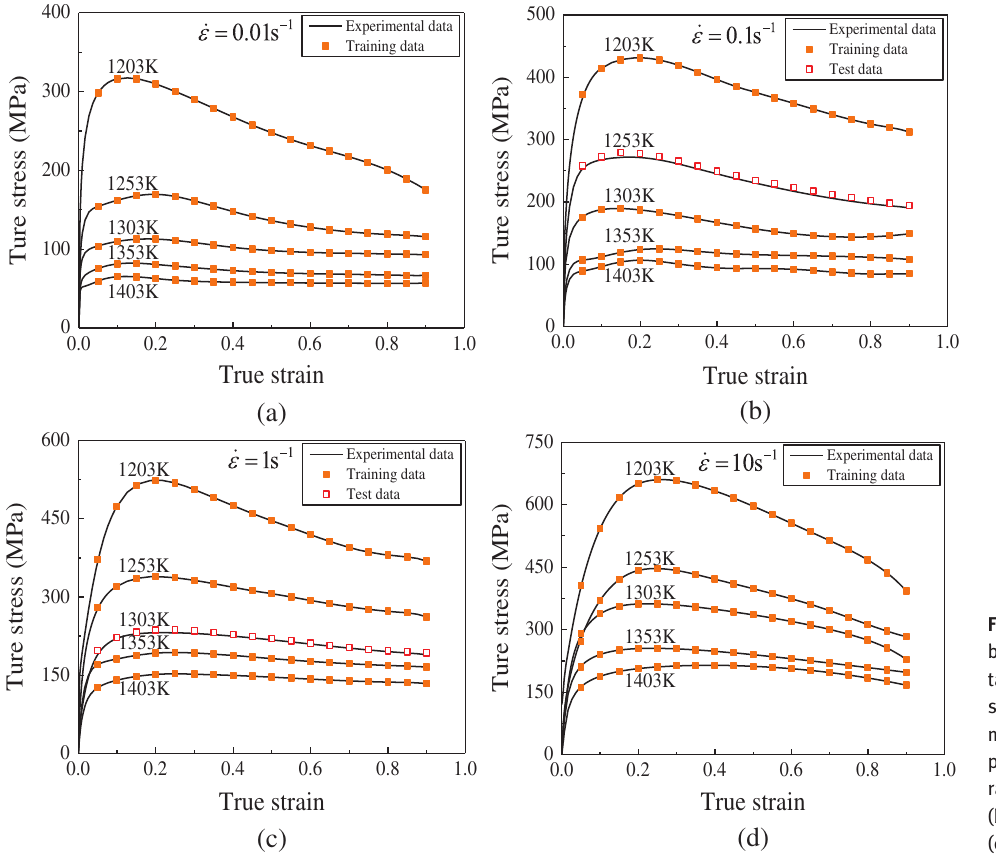
Figure 7: The comparison between the experimen- tal and predicted true stress by the BP-ANN model at different tem- peratures and the